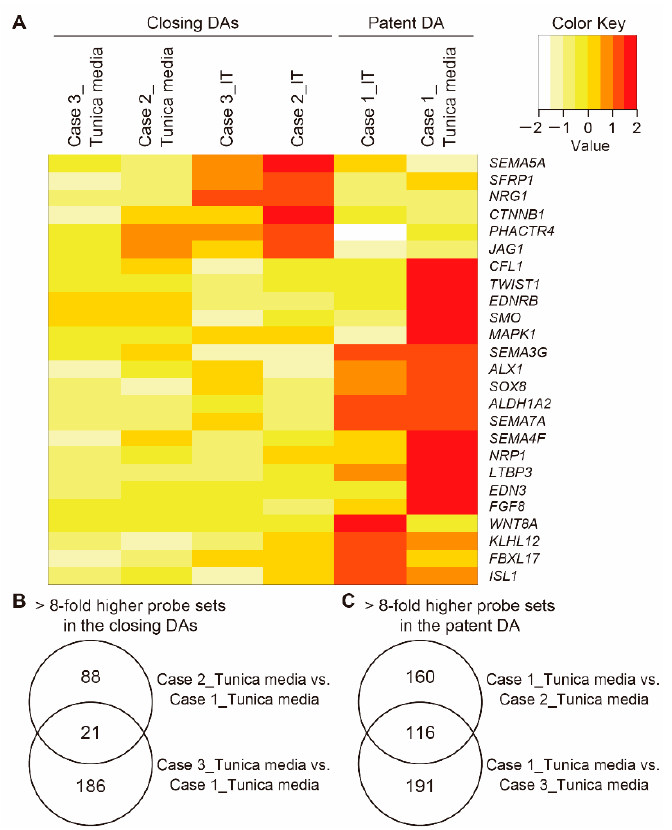
Figure 4. Differential gene expression between the tunica media of the closing human ductus arteriosus (DA) tissues and that of the patent DA tissue. ( A ) A heatmap of vascular cell lineage-related genes is depicted. ( B ) A Venn diagram shows the number of probe sets that were highly expressed (>8-fold) in the tunica media of closing DA tissues (Cases 2 and 3) compared to that of the patent DA tissue (Case 1). ( C ) A Venn diagram shows the number of probe sets highly expressed (>8-fold) in the tunica media of the patent DA tissue (Case 1) compared to that of the closing DA tissues (Cases 2 and 3). IT, intimal thickening.